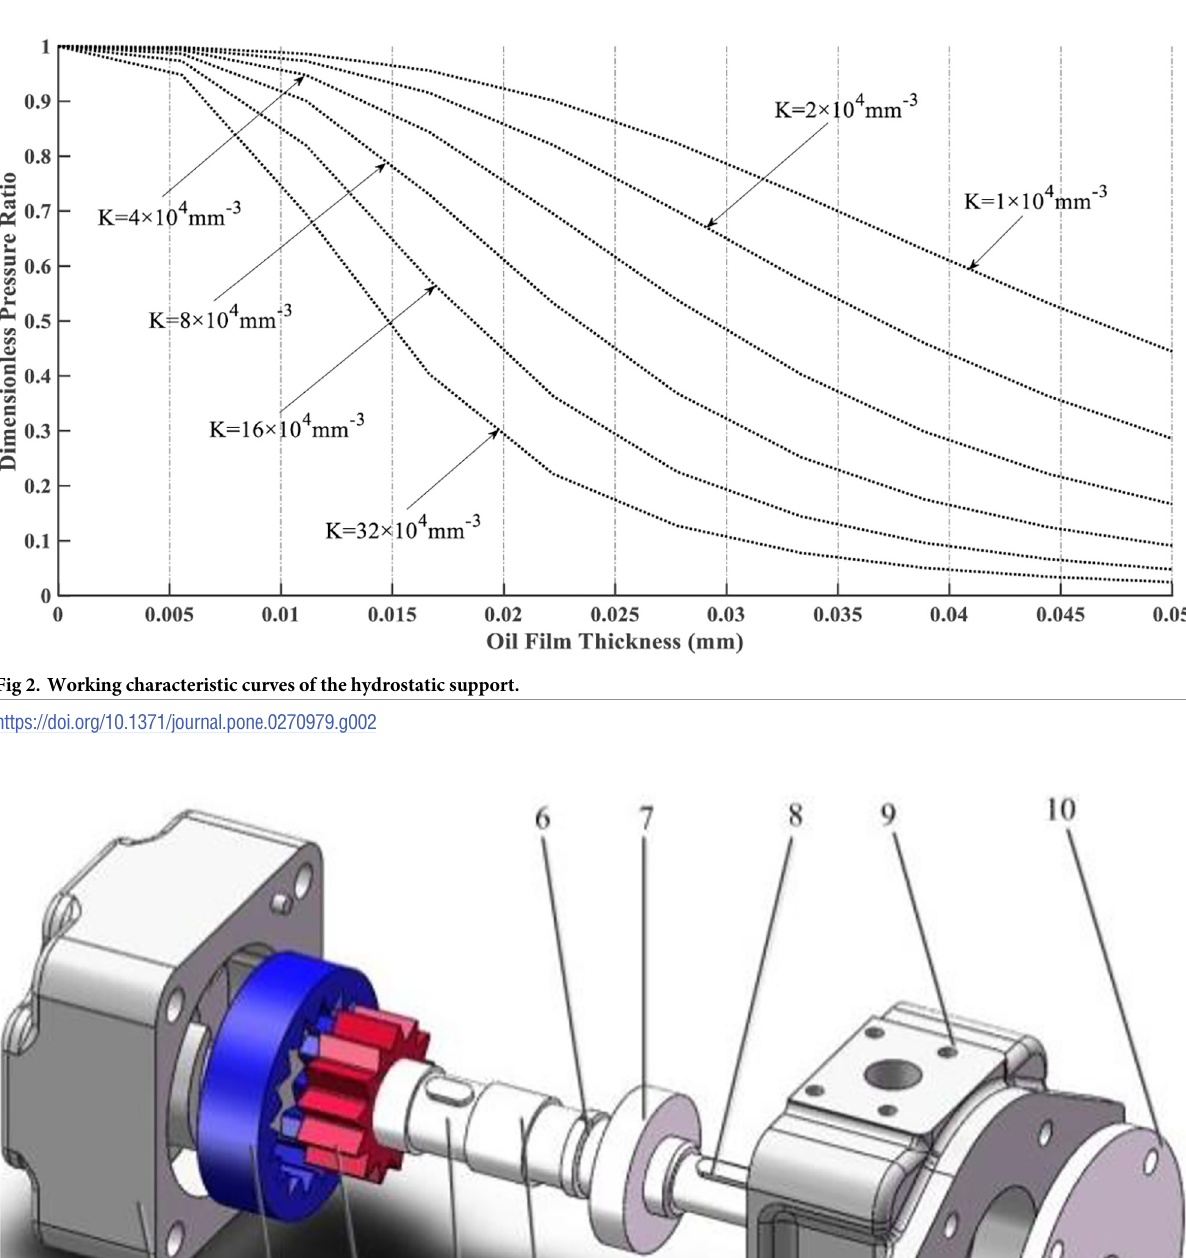
PLOS ONE | https://doi.org/10.1371/journal.pone.0270979 July 28,